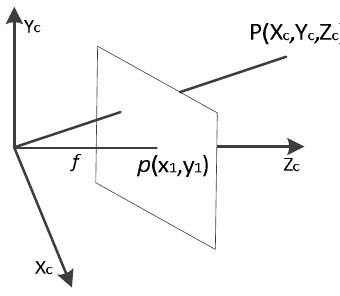
Figure 6. Visual model of camera imaging.